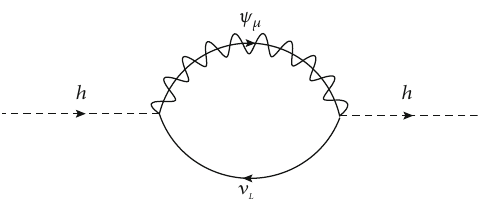
Figure 1: The ψ the Higgs